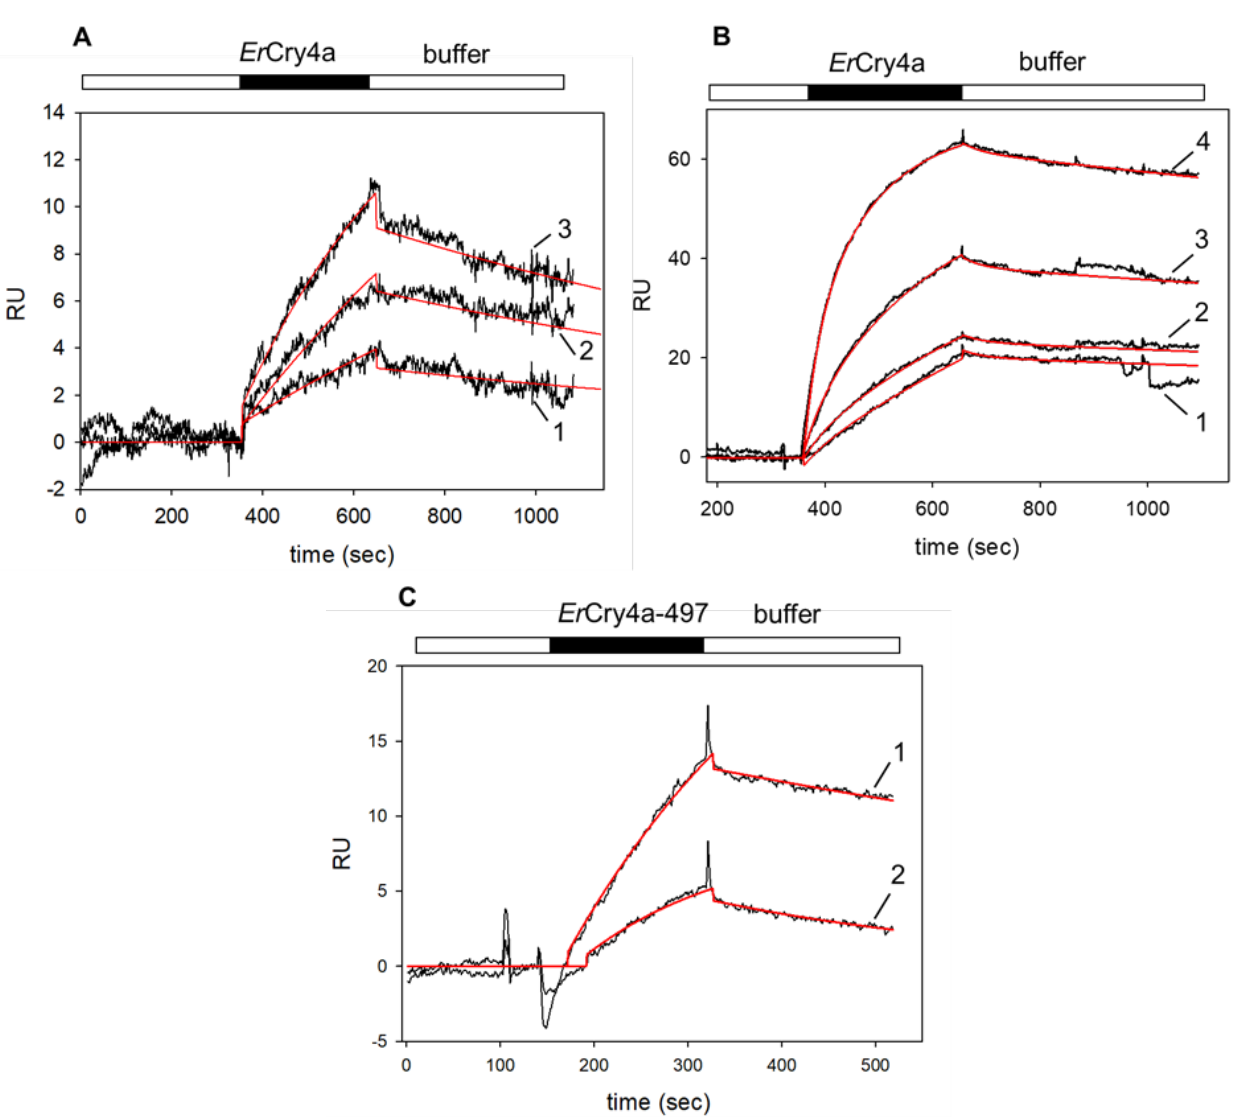
Figure 1. SPR recordings of Er Cry4a interacting with the immobilized G t α /Gi α chimera. Black bars indicate the association phase, open bars indicate buffer flow. For all recordings, we observed that larger RU values resulted from the injection of higher Er Cry4a concentrations. ( A ) Sensorgrams obtained after flushing of 50 nM (1), 100 nM (2) and 500 nM (3) Er Cry4a over immobilized myristoylated G t α /Gi α , which led to the formation of an Er Cry4a-G t α /Gi α complex. Global curve fitting (two- state-reaction model, red lines) resulted in an association rate constant k a1 = 3.32 × 10 3 M − 1 s − 1 and a dissociation rate constant k d1 = 6.74 × 10 − 4 s − 1 , K D = 0.20 µ M. ( B ) Binding of Er Cry4a to non- myristoylated G t α /Gi α after flushing 5 nM (1), 10 nM (2), 20 nM (3) and 50 nM (4) Er Cry4a over immobilized G t α /Gi α . Global curve fitting (two-state-reaction model, red lines) yielded the following constants: k a1 = 3.43 × 10 5 M − 1 s − 1 ; k d1 = 0.011 s − 1 yielding a K D = 32 nM. ( C ) Injection of 500 nM truncated Er Cry4a-497 over myristoylated (1) and non-myristoylated (2) G t α /Gi α , upper and lower curve, respectively. Curve fitting (red lines) to a Langmuir binding model yielded for the upper sensorgram: k ass = 5.35 × 10 3 M − 1 s − 1 ; k diss = 9.15 × 10 − 4 s − 1 ; for the lower sensorgram: k ass = 6.51 × 10 3 M − 1 s − 1 ; k diss = 3.05 × 10 − 3 s − 1